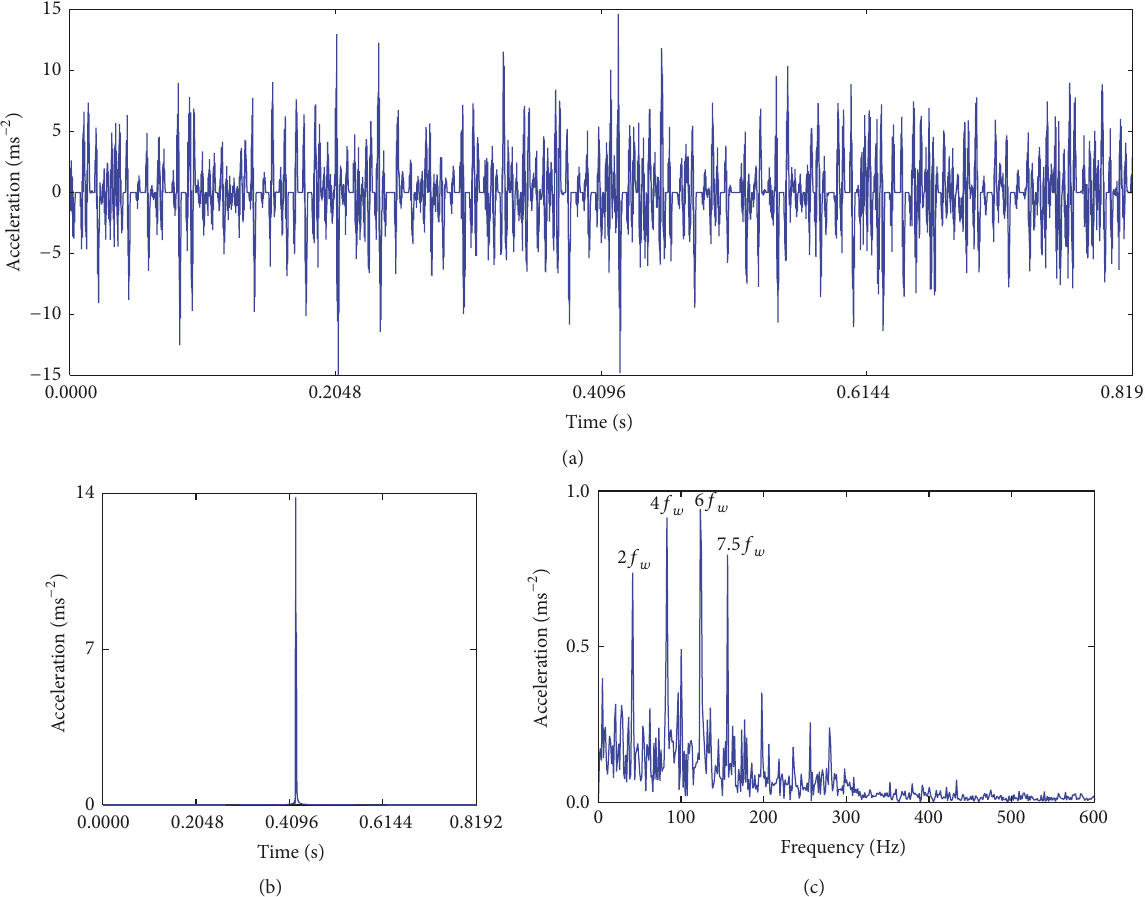
Figure 23: The extracted impulse related to atom 2: (a) by proposed appropriately sparse impulse extraction; (b) three other indicators; (c) the envelope spectra of